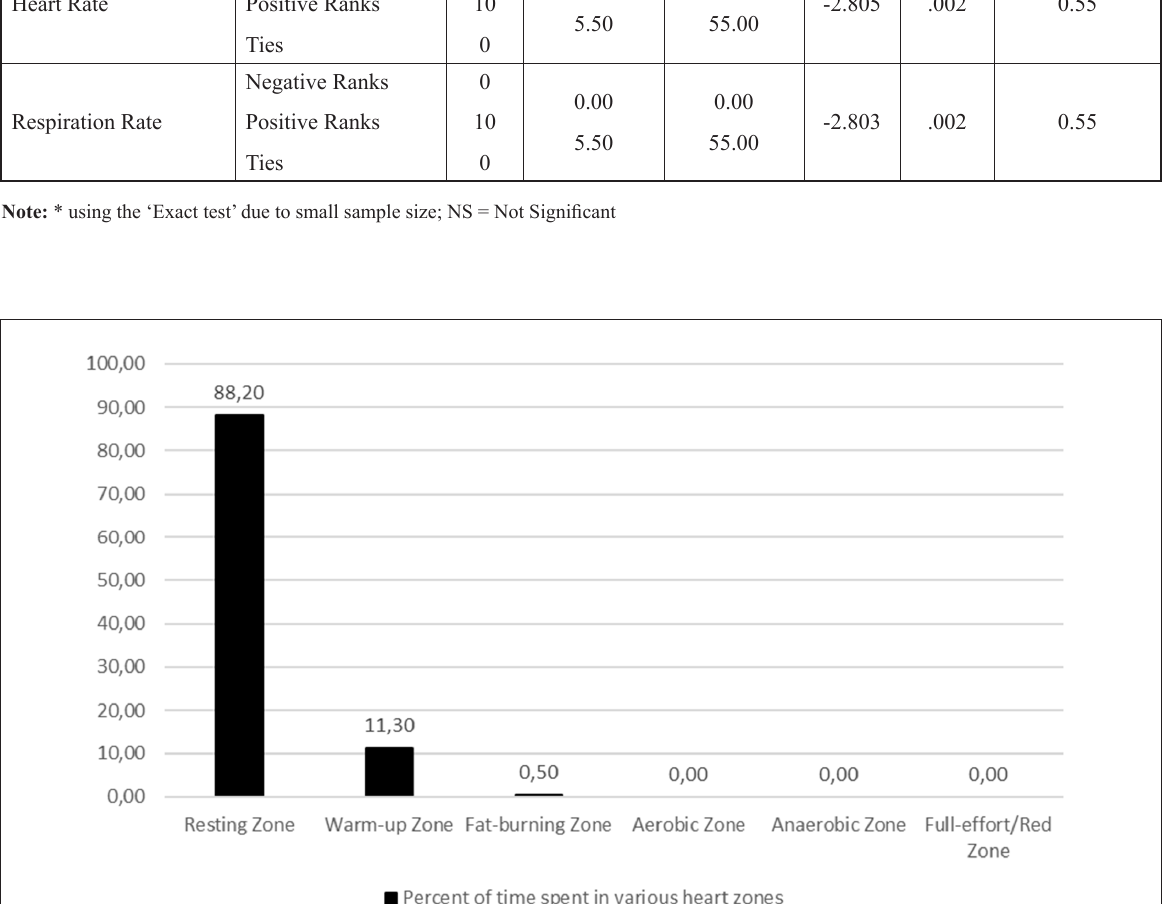
Means ± standard deviations and the results of the univariate repeated measures analysis of variance determining the differences in psychological measures pre- and post-laughter yoga session (Study 2).